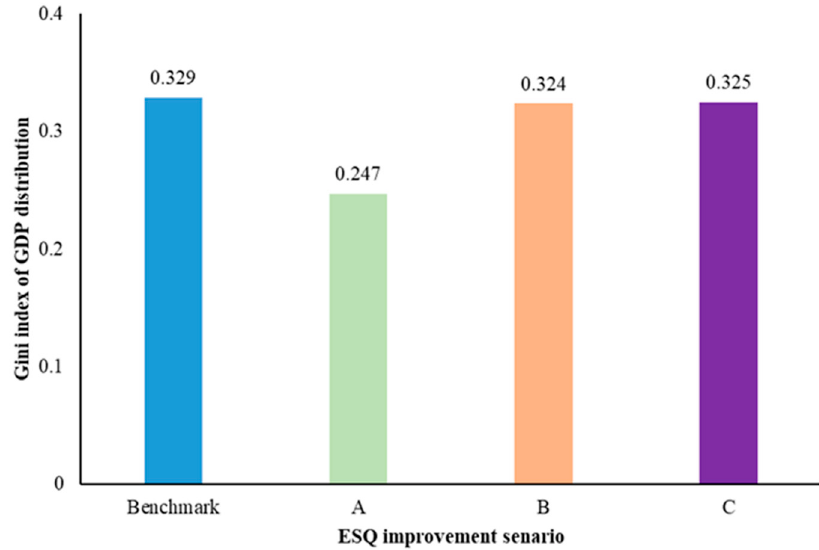
Figure 5. The effect of ESQ improvement on narrowing regional economic gap.